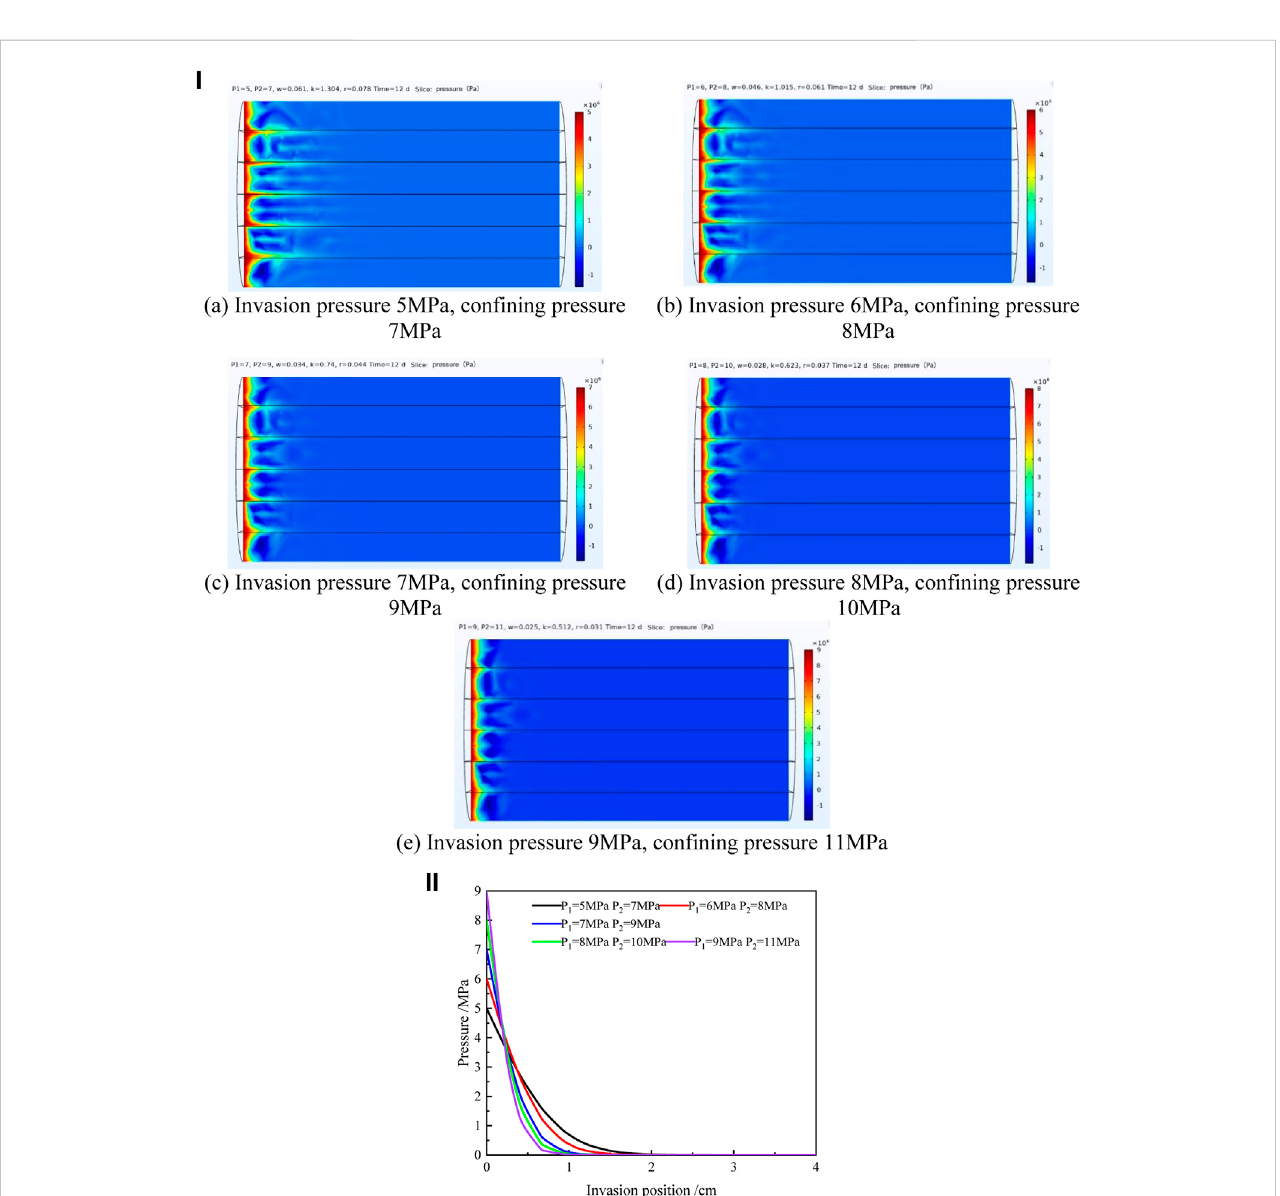
FIGURE 11 (i) : Cloud diagram of the invasion effect under different invasion and con fi ning pressures. (A) Invasion pressure 5 MPa, con fi ning pressure 7 MPa, (B) invasion pressure 6 MPa, con fi ning pressure 8 MPa, (C) invasion pressure 7 MPa, con fi ning pressure 9 MPa, (D) invasion pressure 8 MPa, con fi ning pressure 10 MPa, (E) invasion pressure 9 MPa, and con fi ning pressure 11 MPa. (ii) : Changes of fl uid pressure between bedding fractures with invasion position under different invasion and con fi ning